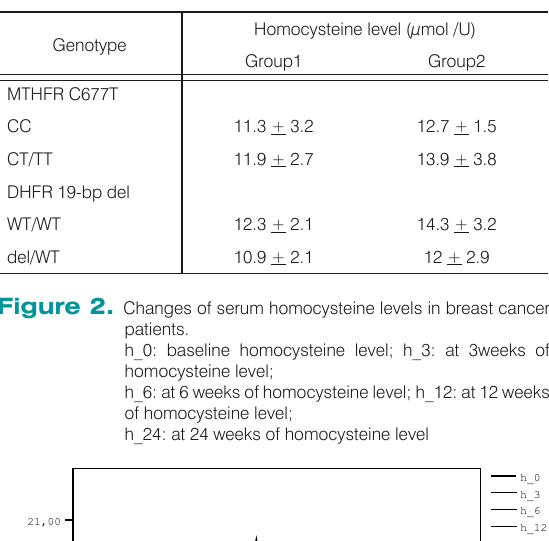
Table 2. The distribution of mean homocysteine values on the basis MTHFR C677T and DHFR 19-bp deletion